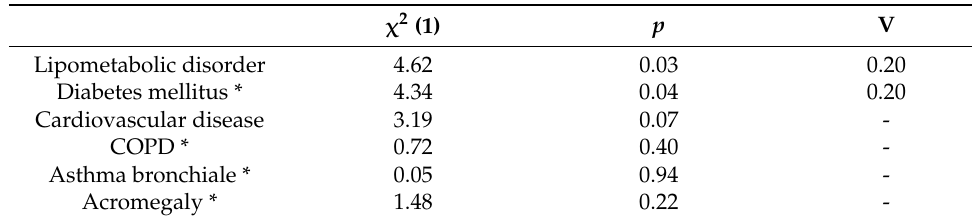
Table 3. Correlation between gender and the pre-existing conditions lipometabolic disorder, diabetes mellitus, cardiovascular disease, COPD, asthma bronchiale and acromegaly. Results of the chi-square tests. V: measure of the effect size.